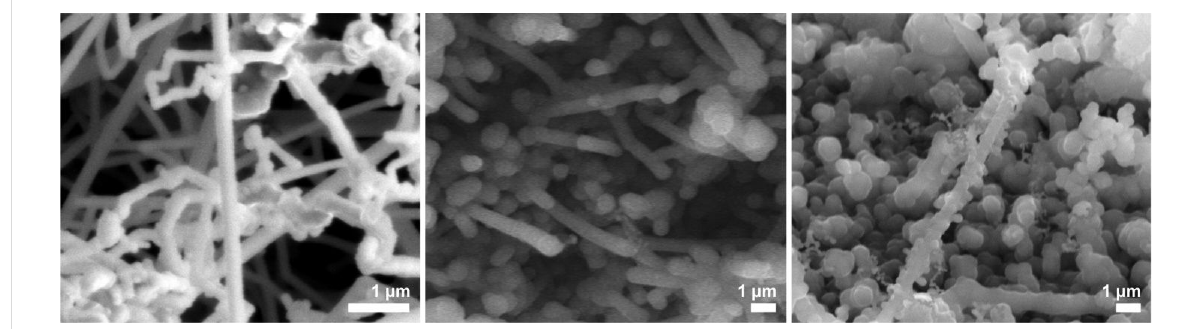
Figure 6: SEM image of NWs grown at 650 °C for 1 h on Si[111] surfaces with annealed gold films (left: sample 1a; center: sample 2a; right: sample 3a).